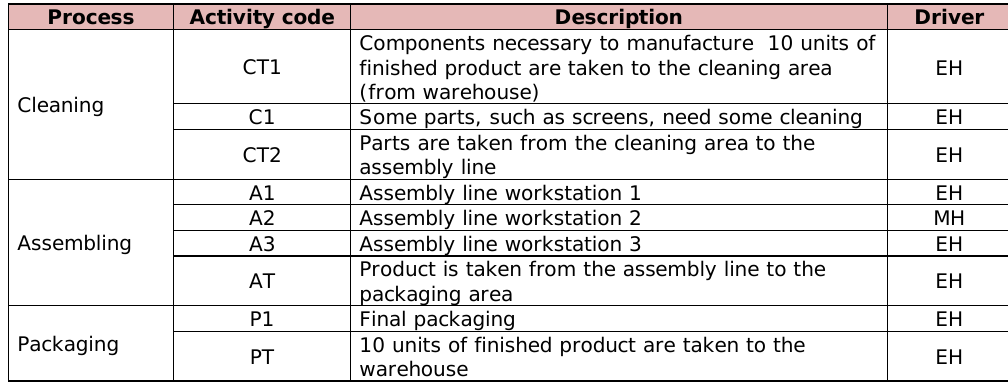
Table 5. “Activities and cost drivers”. EH: Employee-hour. MM: Machine-hour.